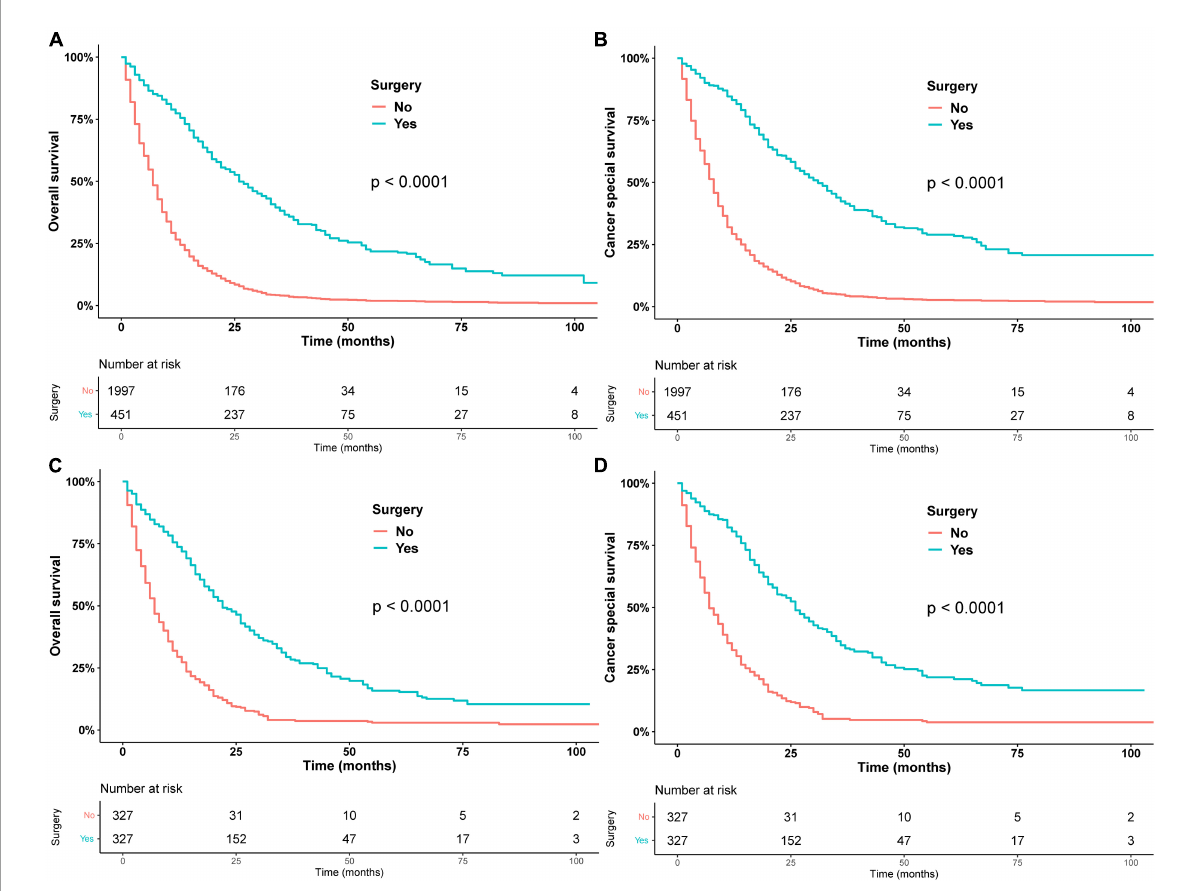
FIGURE1 Overall survival in patients who underwent surgery or did not undergo surgery before PSM (A) and after PSM (C) . Cancer-specific survival in patients who underwent surgery or did not undergo surgery before PSM (B) after PSM (D) .